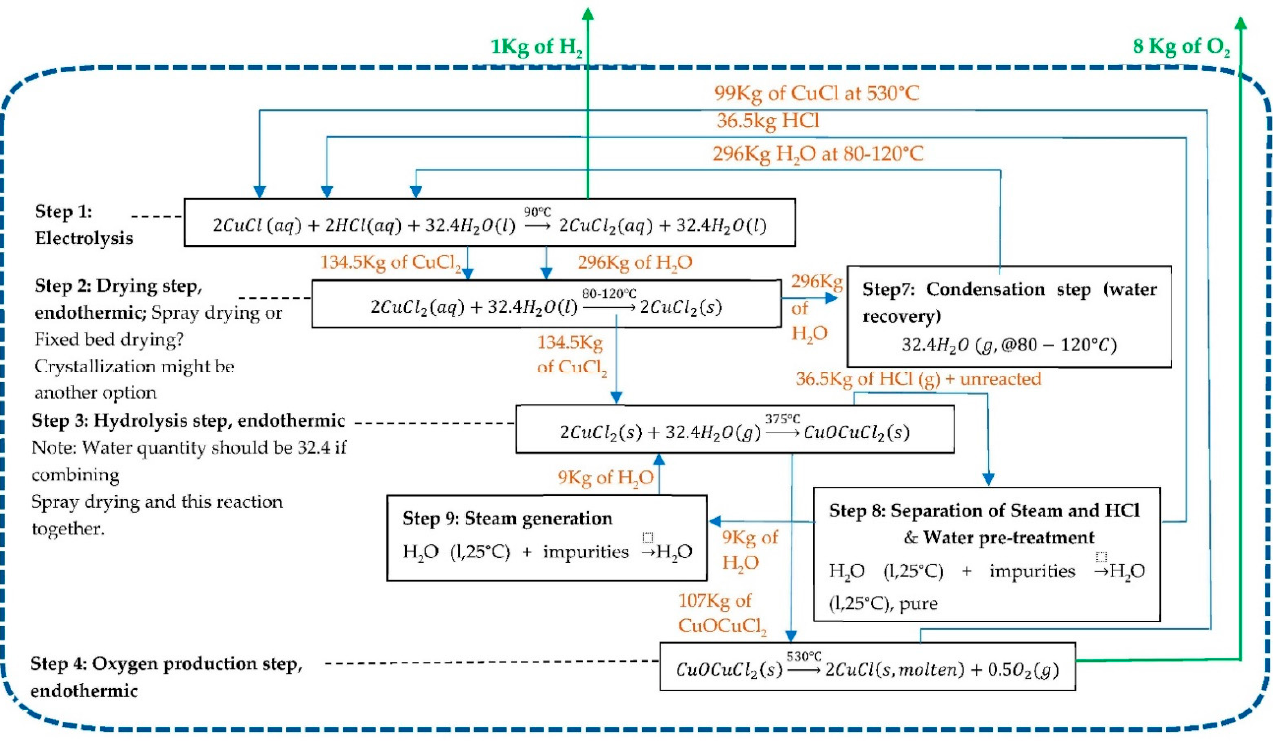
Figure 1. Stoichiometric chart of the Cu-Cl cycle (adopted from [4–8]). T he amount of water for quenching is calculated based on the stoichiometric propor-